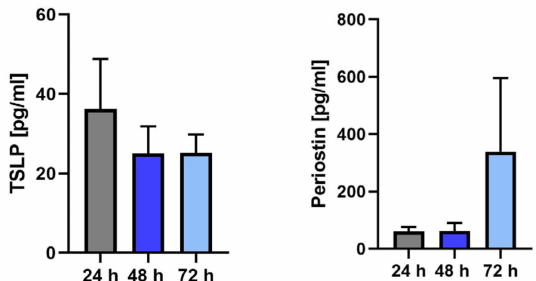
Figure 6. The function of epithelial cells from cryopreserved tissues was assessed by the production of typical cytokines and proteins of type 2 inflammation, representatively TSLP and periostin. The cells were able to produce TSLP and periostin, demonstrating sufficient functioning of the epithelial cells for further study. TSLP concentration (n = 3): 36.22 ± 12.62 pg/mL in 24 h; 24.96 ± 6.917 pg/mL in 48 h; and 25.22 ± 4.619 pg/mL in 72 h. Periostin concentration (n = 3): 60.45 ± 15.70 pg/mL in 24 h; 62.10 ± 28.14 pg/mL in 48 h; and 338.7 ± 256.9 pg/mL in 72